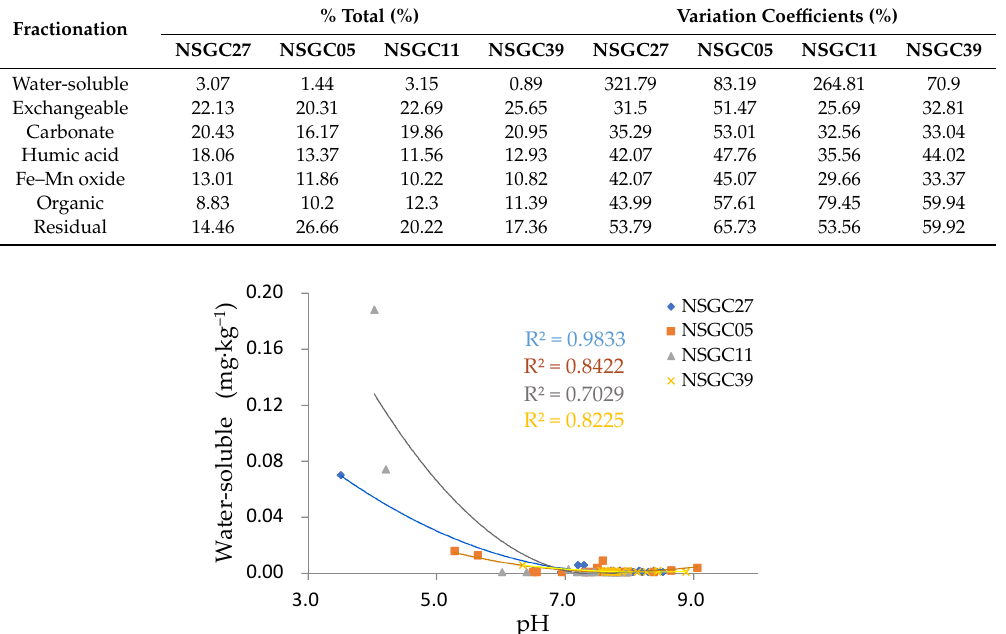
Figure 11. Correlation between Cd water solubility and the pH value for each core.